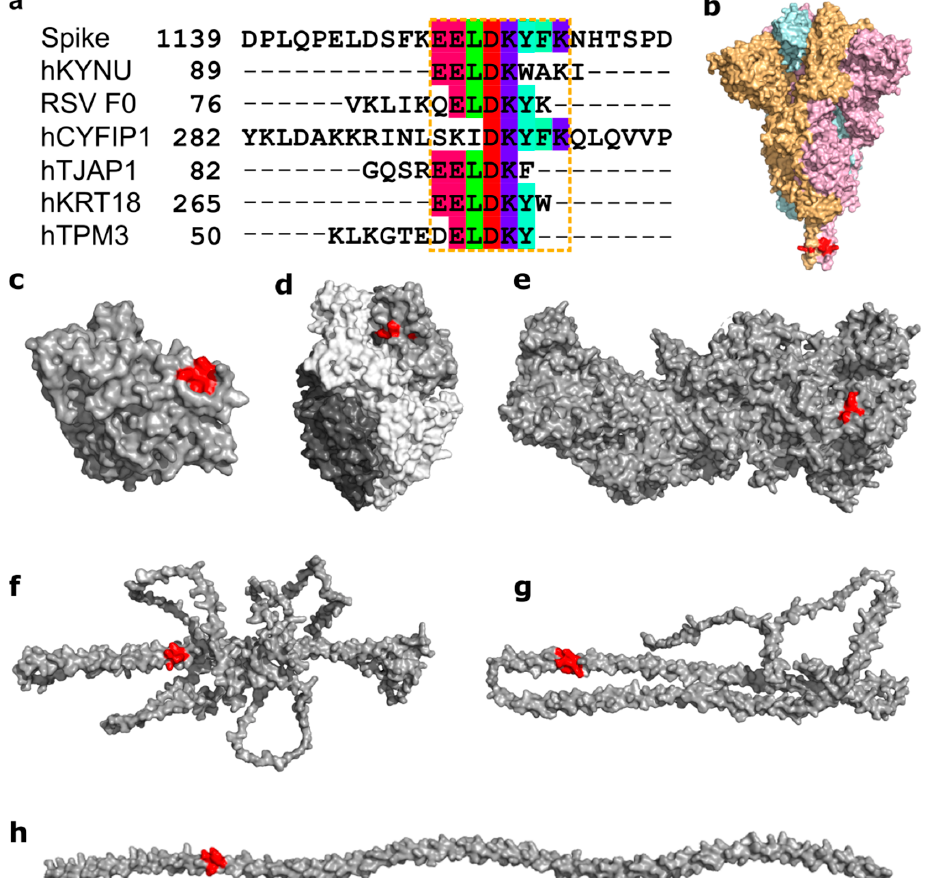
Figure 6. Structural mimicry between an ELDKY motif in SARS ‐ CoV ‐ 2 Spike and epitopes in six other proteins. ( a ) Sequence alignment between SARS ‐ CoV ‐ 2 Spike and the epitopes containing the 3D ‐ mimicry motif for human kynureninase (hKYNU, IEDB Epitope ID: 1007556), respiratory syncytial virus fusion F0 glycoprotein (RSV F0, IEDB Epitope ID: 1087776), human cytoplasmic FMR1 ‐ interacting protein 1 (hCYFIP1, IEDB Epitope ID: 1346528), human tight junction ‐ associated protein 1 (hTJAP1, IEDB Epitope ID: 1016424), human keratin type I cytoskeletal 18 (hKRT18, IEDB Epitope ID: 1331545), and human tropomyosin alpha ‐ 3 (hTPM3, IEDB Epitope ID: 938472). Residues in the molecular mimicry motifs are colored by Taylor [65]. The extended molecular mimicry region is highlighted by the orange dashed box. ( b ) Surface representation of Spike (PDB id: 6XR8) colored by subunit (beige, pink, light blue) with ELDKY motif indicated in red. Surface representation of proteins (gray) with full or partial 3D ‐ mimics of the ELDKY motif (red): ( c ) hKYNU (PDB id: 2HZP), ( d ) RSV F0 (PDB id: 6EAE), ( e ) hCYFIP1 (PDB id: 4N78), ( f ) hTJAP1 (Uniprot: Q5JTD0), ( g ) hKRT18